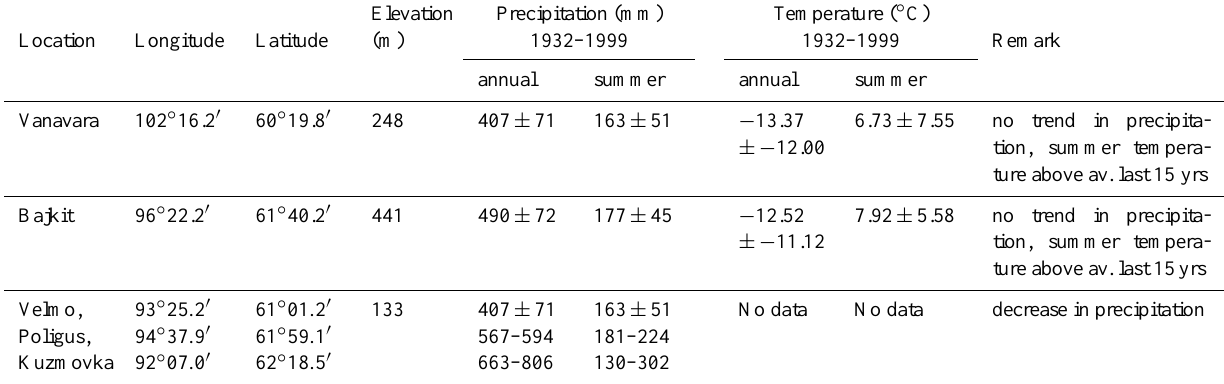
Table 1. Long-term averages of precipitation ( P ) and temperature ( T ) along the River